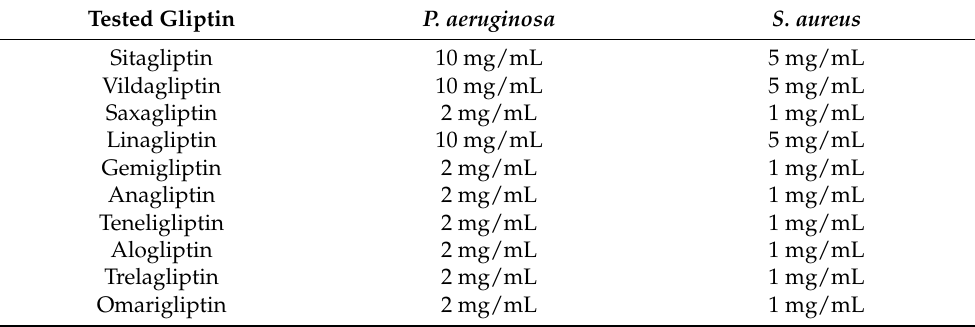
Table 2. MICs of gliptins for P. aeruginosa (ATCC 27853) and S. aureus (ATCC 6538). Tested Gliptin P. aeruginosa S. aureus Sitagliptin 10 mg/mL 5 mg/mL Vildagliptin 10 mg/mL 5 mg/mL Saxagliptin 2 mg/mL 1 mg/mL Linagliptin 10 mg/mL 5 mg/mL Gemigliptin 2 mg/mL 1 mg/mL Anagliptin 2 mg/mL 1 mg/mL 2